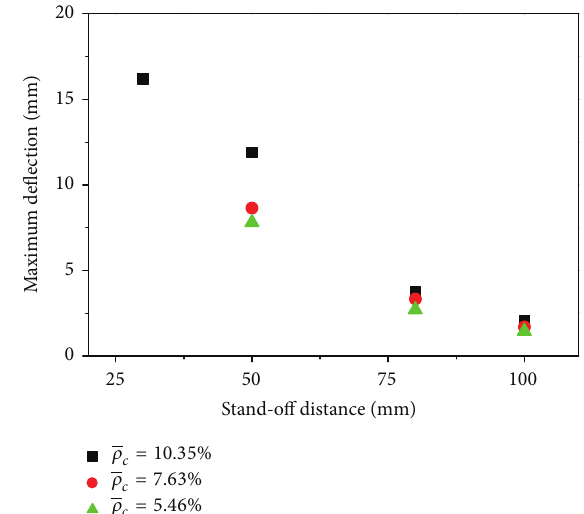
Figure 18: Maximum deflections of front face and back face of sandwich panels with different core web thicknesses.